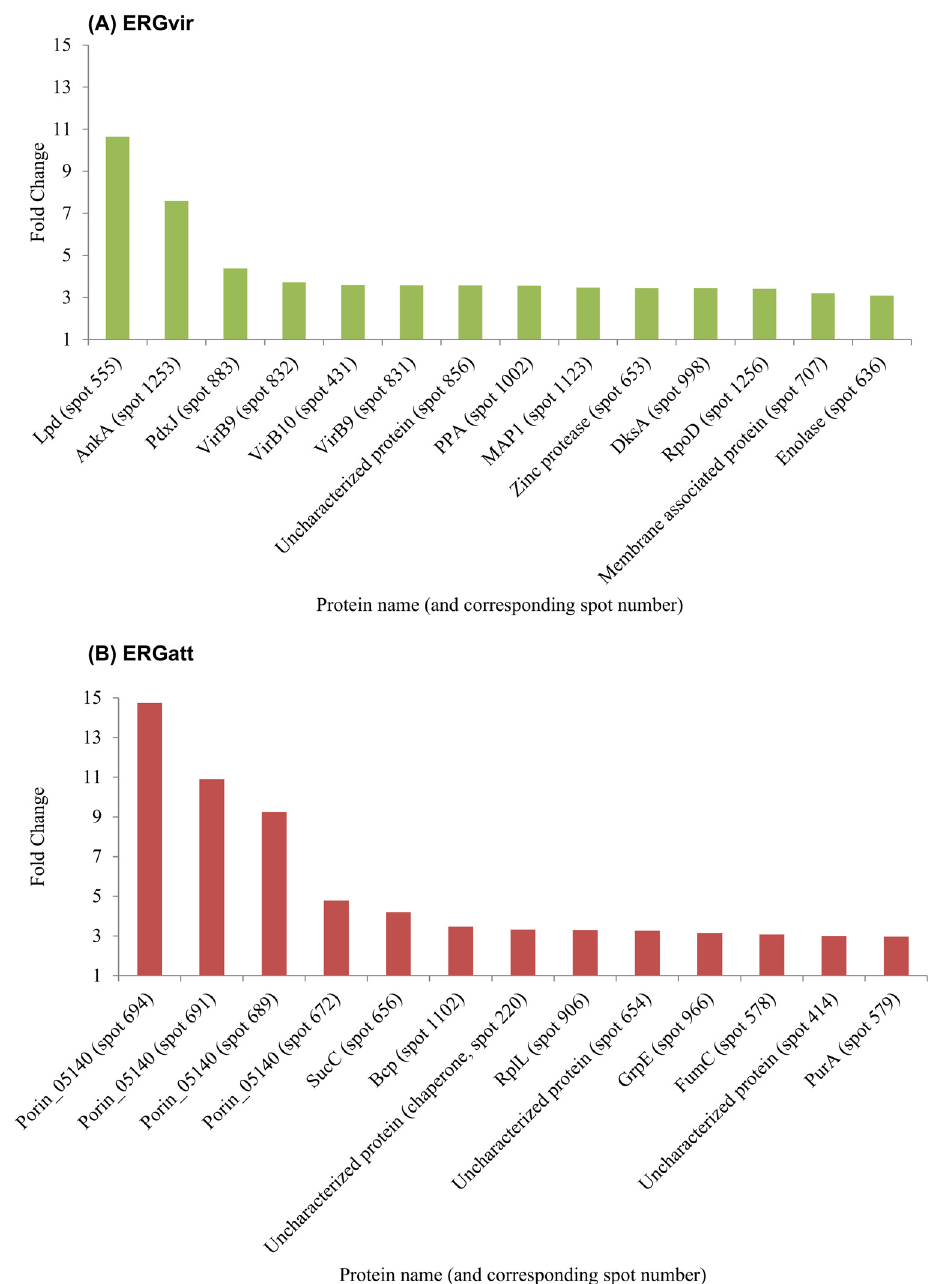
Fig 3. Proteins overexpressed (fold change (cid:1) 3) in ERGvir (A) and ERGatt (B) according to DIGE analyses and MALDI-TOF/TOF.